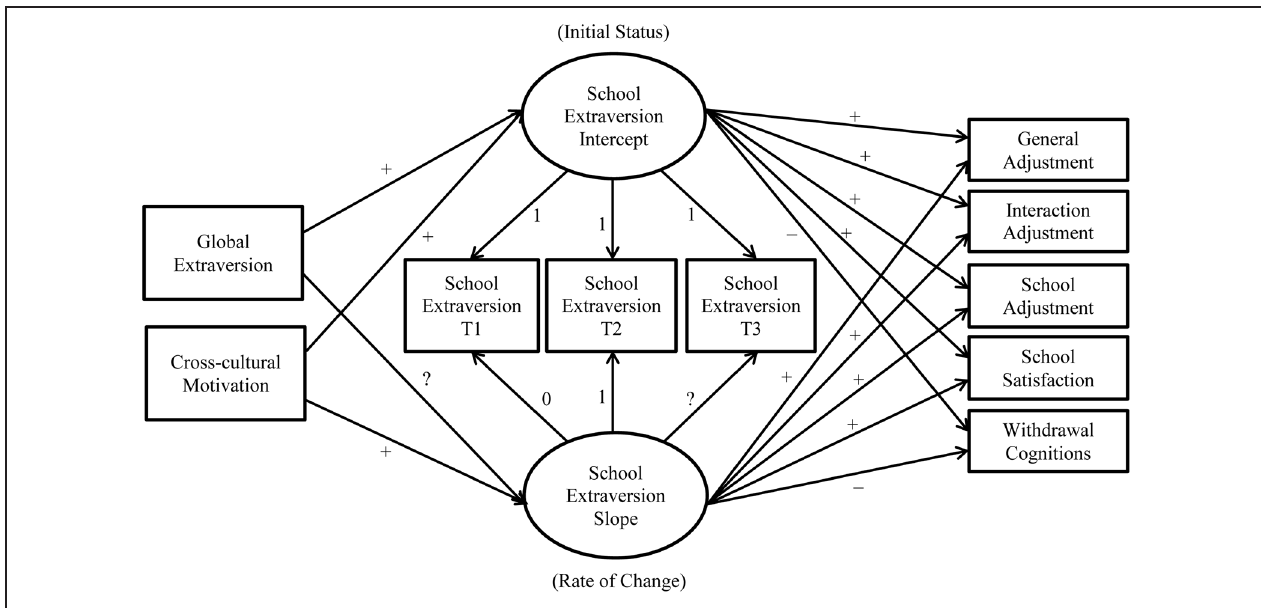
FIGURE 2 | Model 2 with hypotheses.